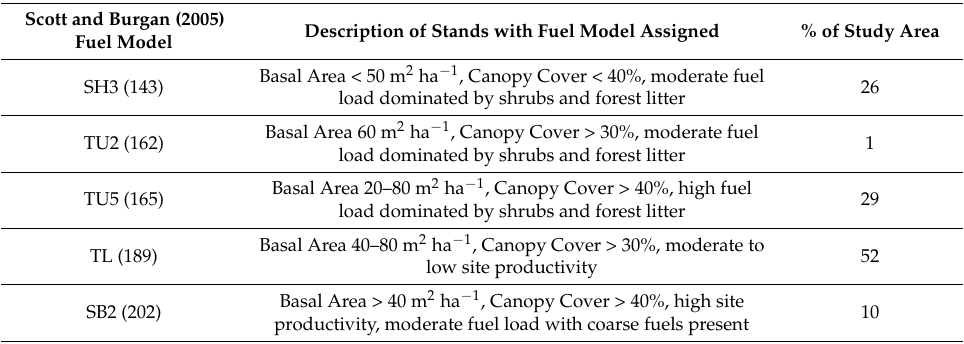
Table 2. Fuel model assignments and their proportion throughout the study area. Fuel model selection logic was based on multiple regression tree analyses using plot-level data for dependent variables (shrub cover and fuel loads by category) and independent forest structure variables from Lidar data (20 m pixel